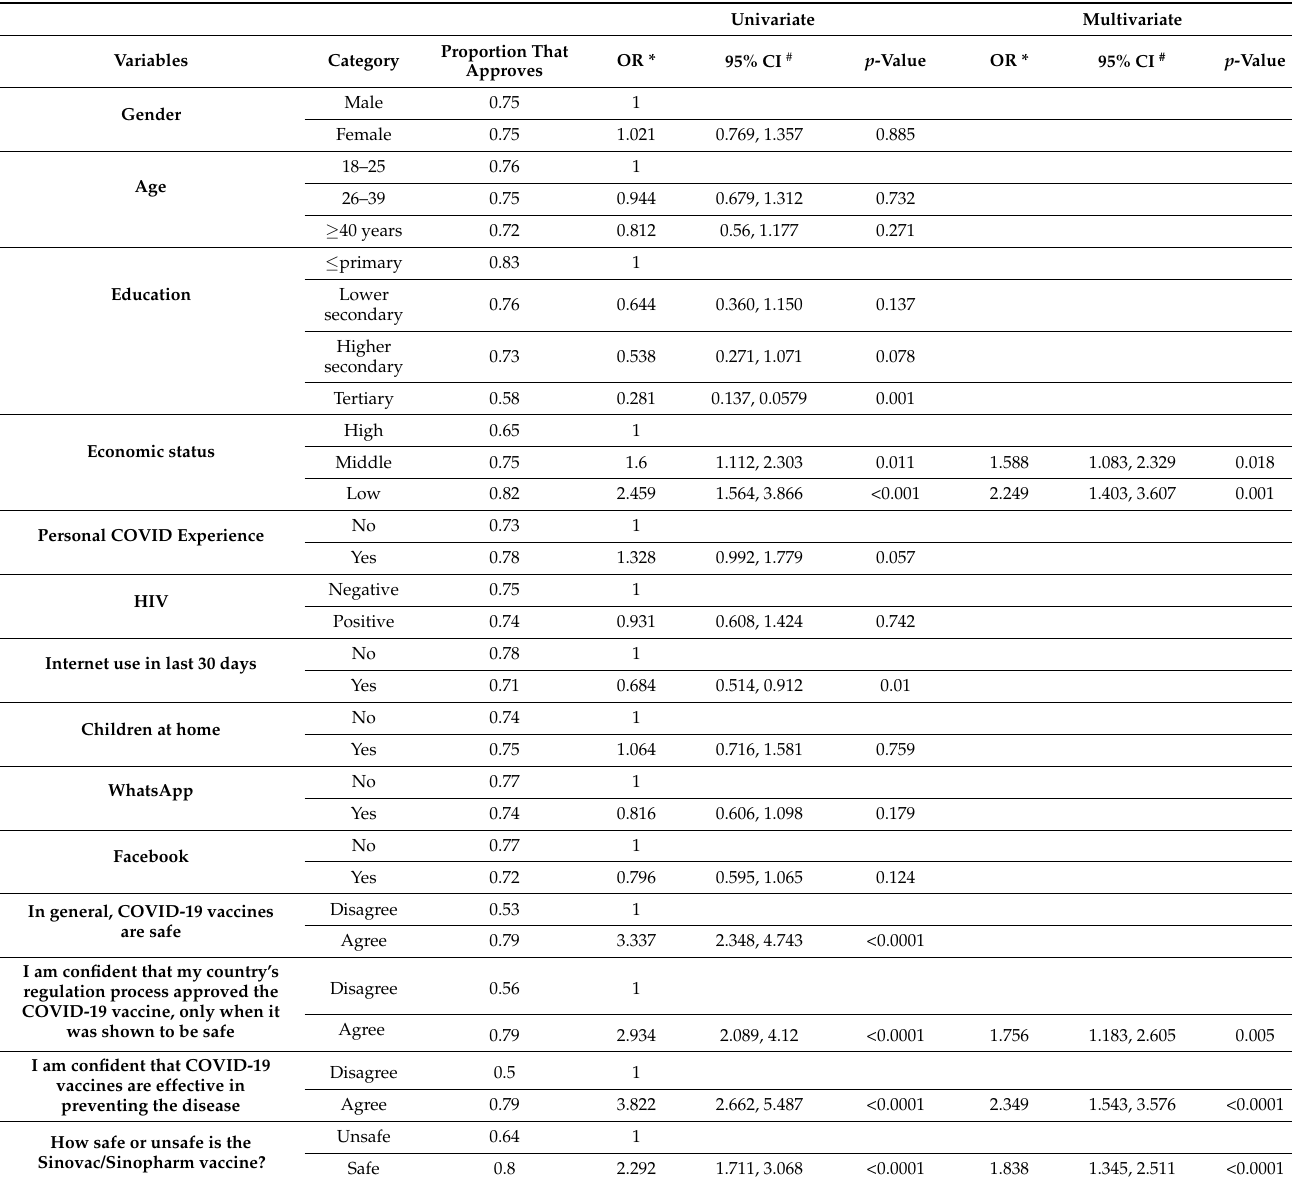
Table 3. Do you approve of the government requiring a COVID-19 vaccine to use public transporta- tion? (strongly/somewhat